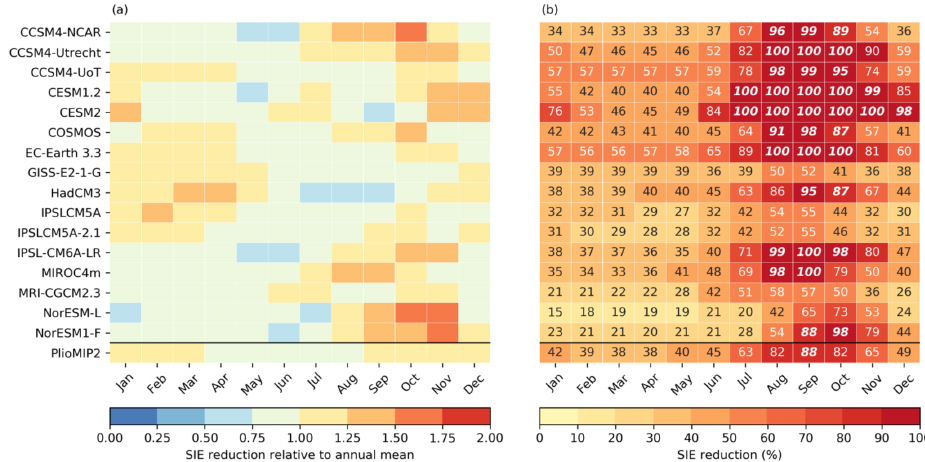
Figure 5. (a) Monthly SIE anomalies relative to annual mean anomalies, warmer colours highlight in which months reductions in sea ice were largest. (b) Reduction in SIE (%) in the mPWP simulations compared to the pre-industrial monthly mean SIE for each month. Highlighted in bold italics in (b) are months with sea-ice-free conditions (SIE < 1 × 10 6 km 2